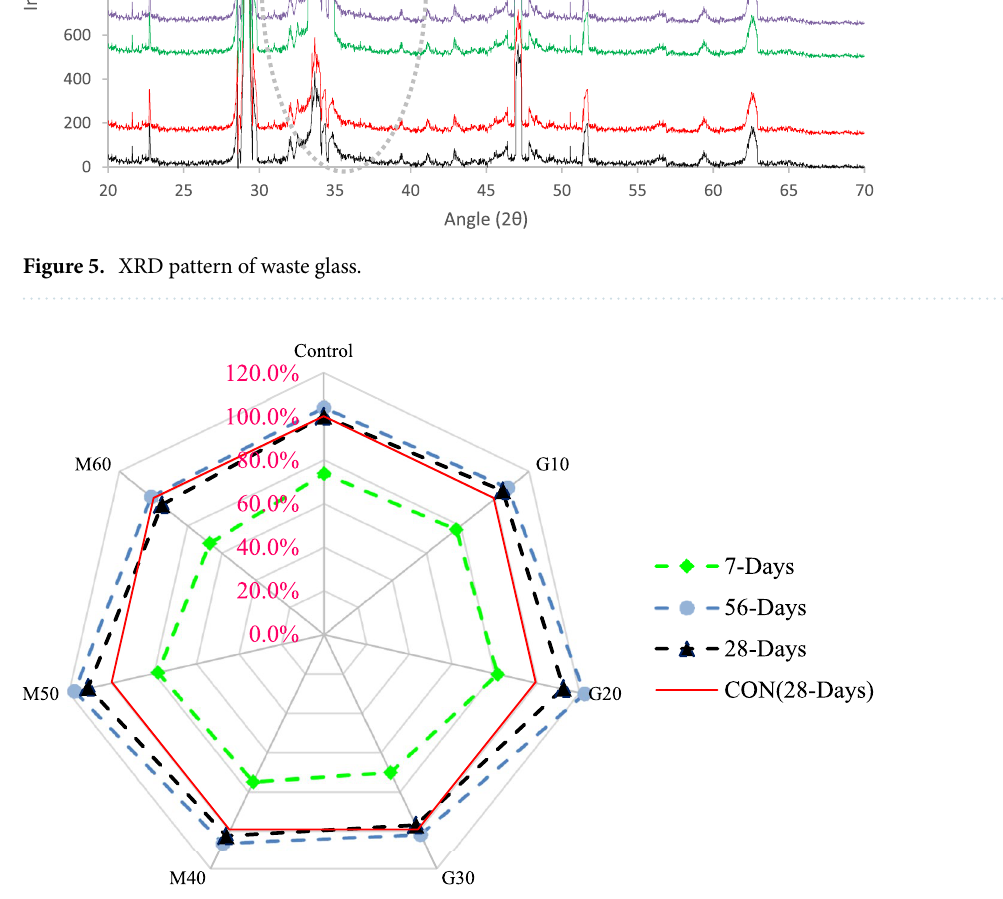
Figure 6. Relative analysis of compressive